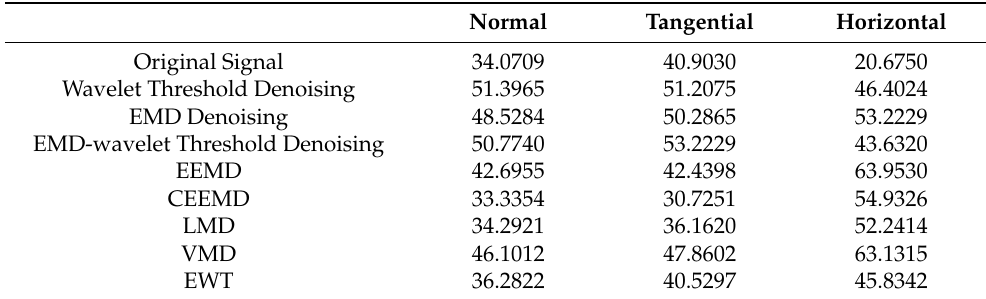
Table 2. SNR of different signal processing methods.